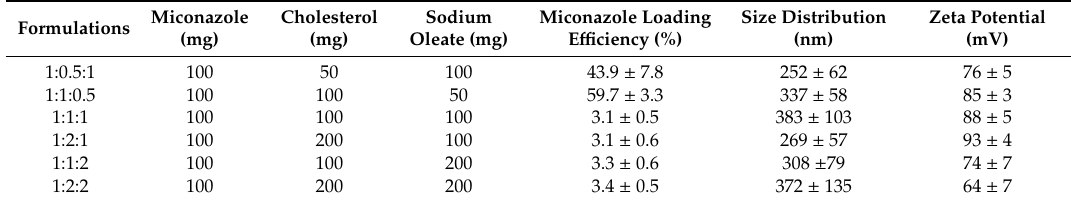
Table 1. Display of the various ratios of miconazole, cholesterol, and sodium oleate used in each formulation. Miconazole was used as the determinant anchor to maintain consistency with testing, and to o ff er a support when comparing with Actavis brand marketed